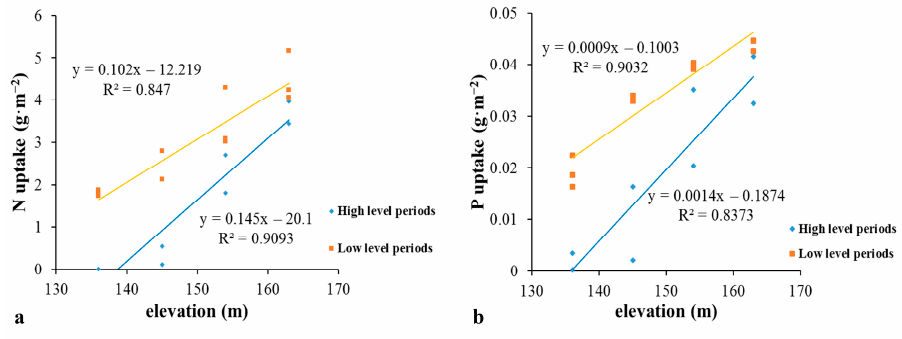
Figure 8. The distribution of N ( a ) and P ( b ) uptake rate responses to different water levels.